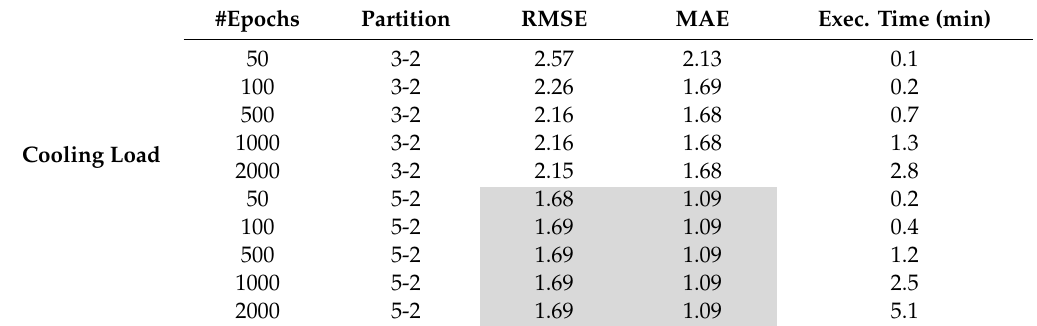
Table 4. Prediction errors obtained by ANFIS for the CL, when the features selected by FIR are used as input variables, that is, RC and GA. The best prediction performances are